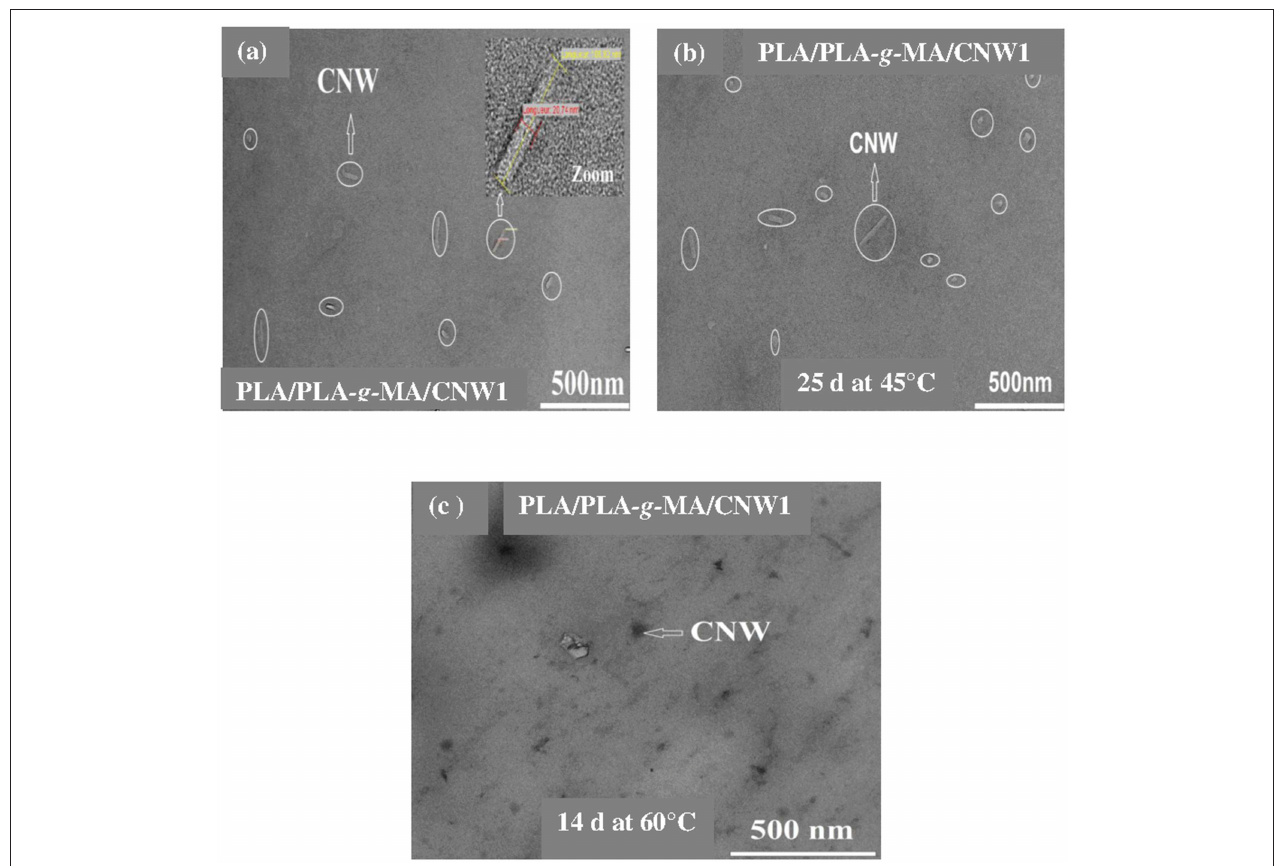
FIGURE 7 | TEM images of a PLA/PLA -g- MA/CNW1 fiber. (a) Before exposure, (b) after 25 days at 45 ◦ C, and (c) 14 days at 60 ◦ C.